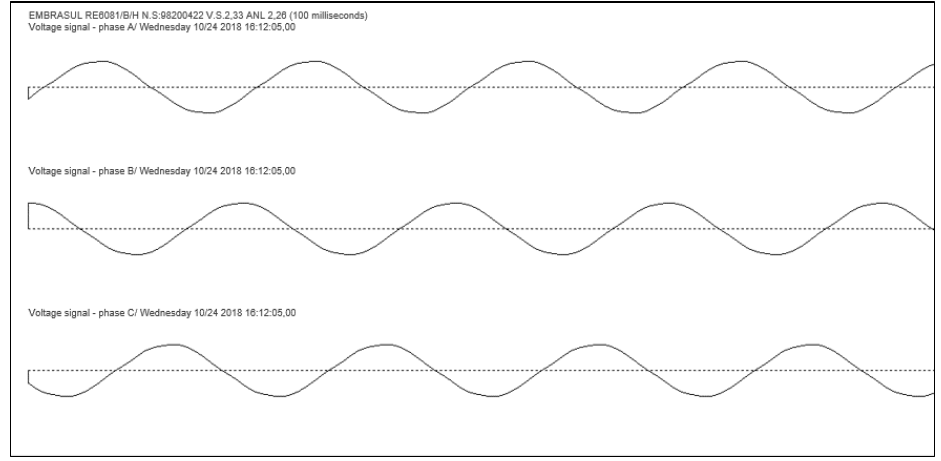
Figure 2: Voltage input to UPS A.